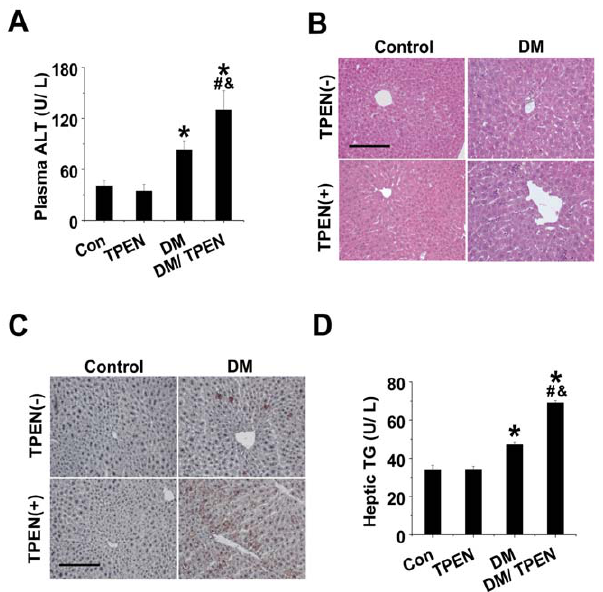
Figure 2. Diabetes and TPEN treatment induced the ALT increase in the plasma and also morphological changes and lipid accumulation in the liver. Plasma ALT levels were measured by infinity TM ALT detection kit (A). Hepatic morphological changes were examined microscopically with H&E staining (40 6 ) (B). Hepatic lipid accumulation (C) and TG levels (D) were examined by Oil Red O staining (40 6 ) and by TG reagent, respectively. Data are presented as mean 6 SD (n=6 at least in each group). DM: diabetes. * P , 0.05 vs. control group; # P , 0.05 vs. TPEN group; & P , 0.05 vs. DM group.